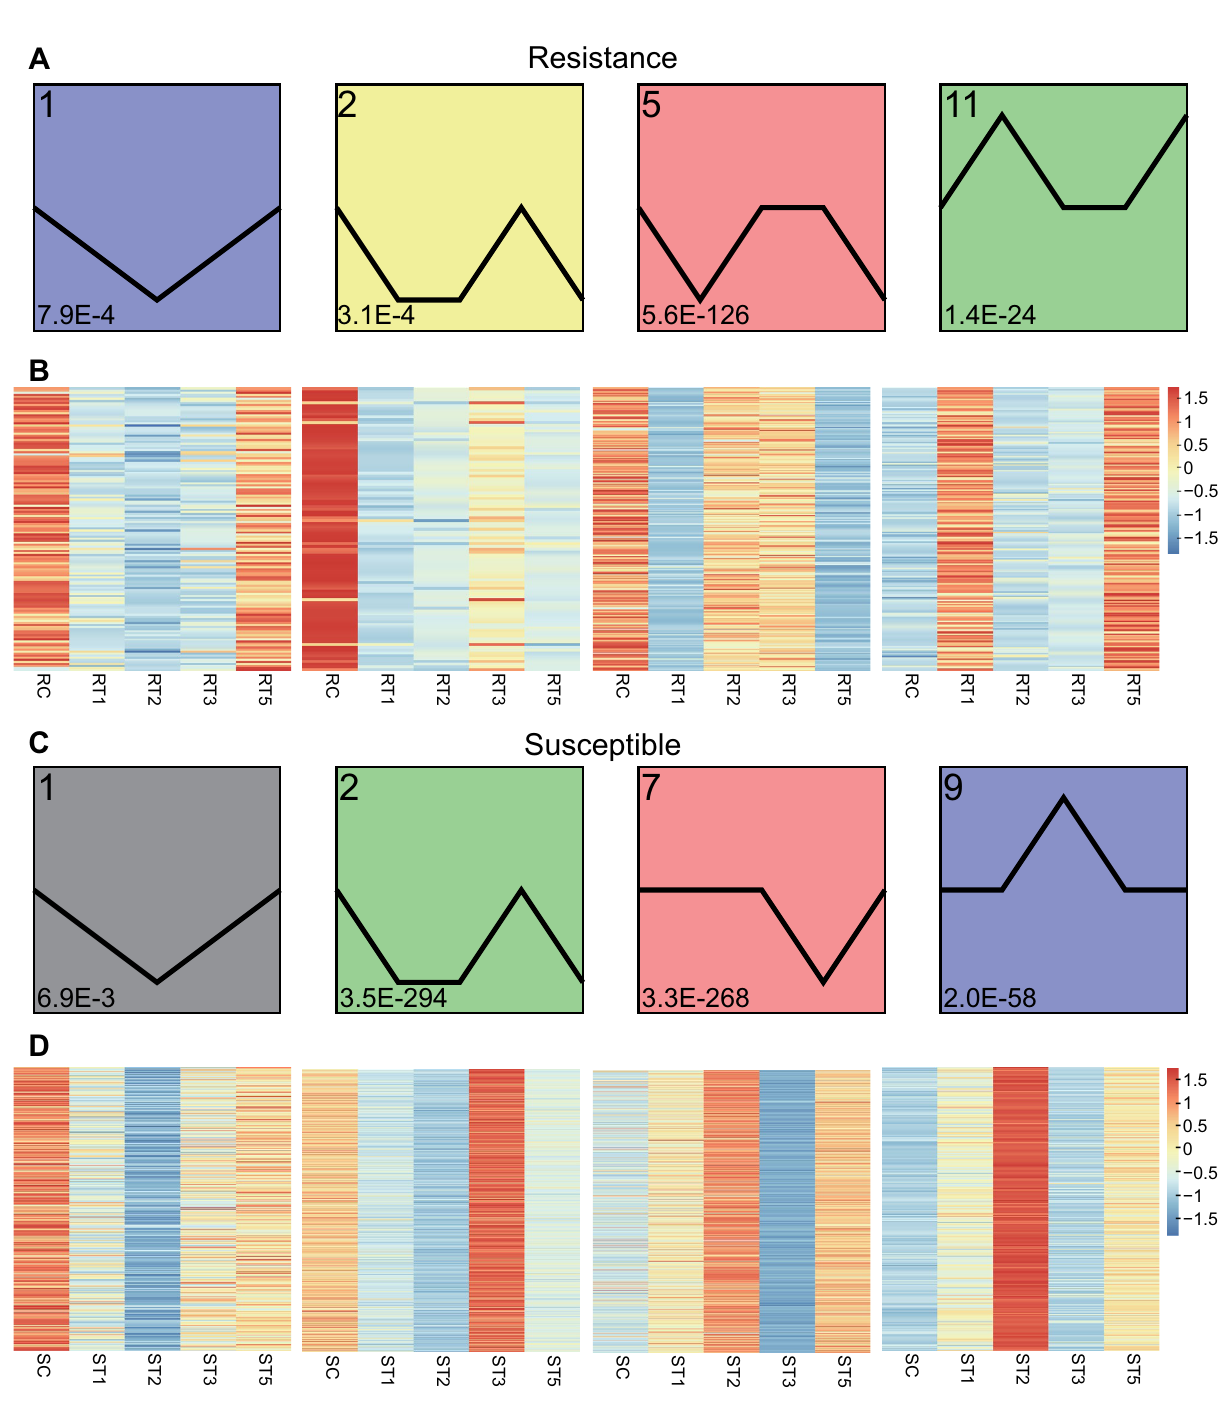
Figure 3. Trend analysis of gene expression in disease-resistant and disease-susceptible cultivars at different time points post infection. ( A ) 4 significant clusters of the resistant cultivar ( p -value < 0.05). ( B ) Heatmap of the 4 significant clusters of the resistant cultivar. ( C ) 4 significant clusters of the susceptible cultivar ( p -value < 0.05). ( D ) Heatmap of the 4 significant clusters of the susceptible cultivar. The heatmap colouring reflects the rank of the Z-scores. Data normalized by Z-score transformation can be used directly in the calculation of significant changes in gene expression between different samples and